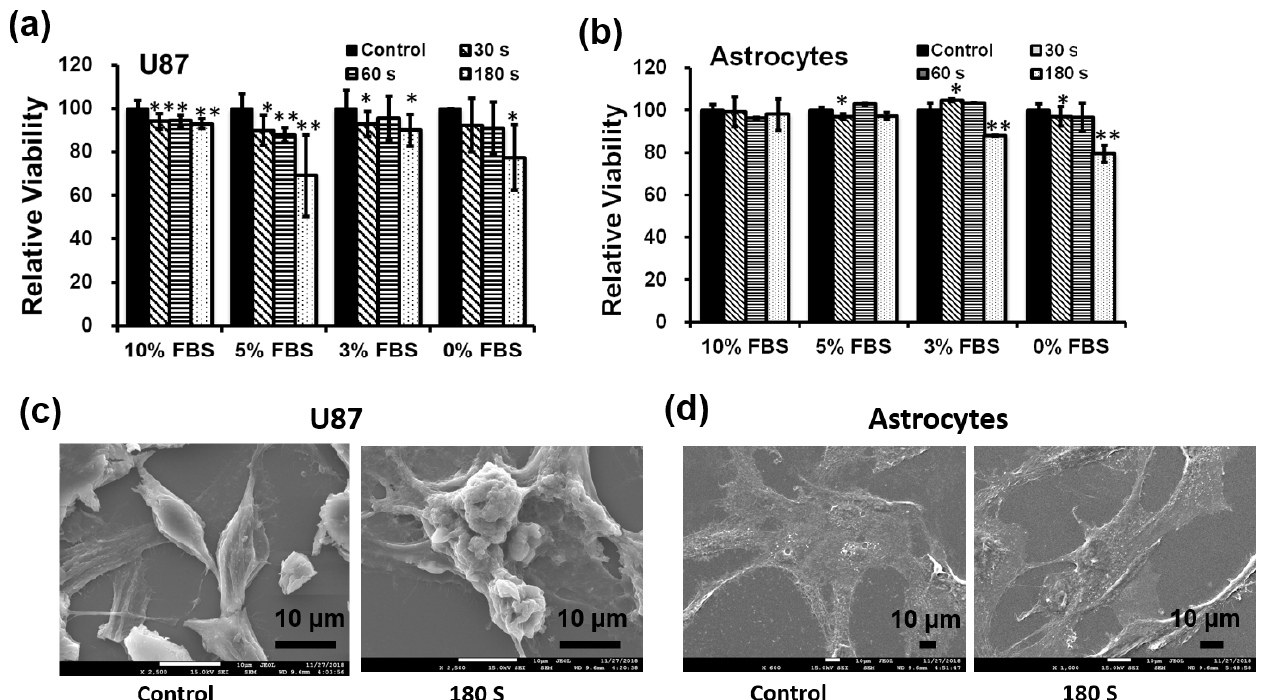
Figure 3. ( a ) Effects of NBP-J on cell viability of U87 MG cell line and ( b ) Astrocytes treated with different concentrations of FBS (fetal bovine serum) for various durations. An Alamar blue assay was performed after 24 h of treatment. Changes in morphology after plasma treatment in ( c ) U87MG and ( d ) astrocytes were viewed by SEM. Data are presented as means ± SD of three independent sets of experiments. * p < 0.05, ** p < 0.01, and *** p <